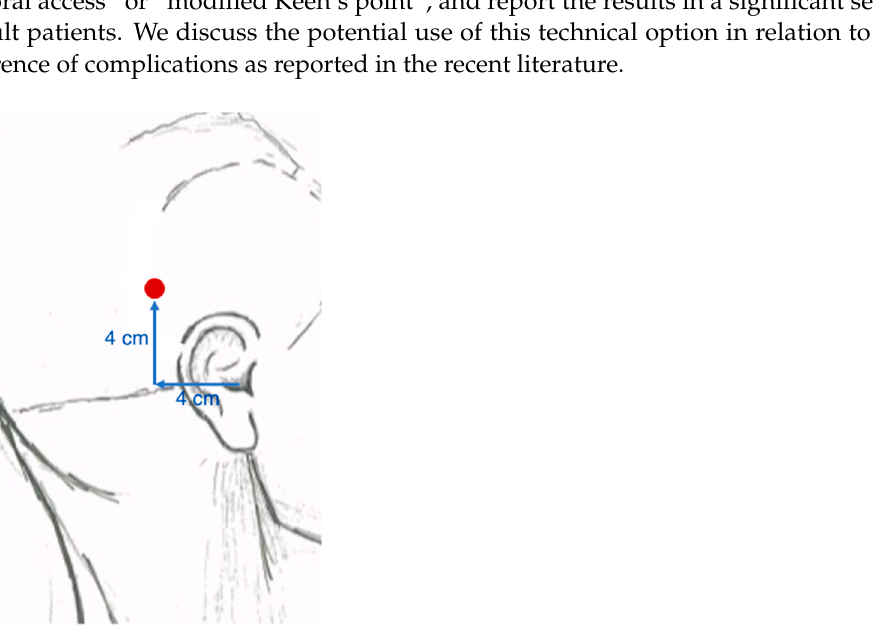
Figure 1. Posterior temporal access or modified Keen’s point (red dot) is taken 4 cm posteriorly and superiorly to the external auditory meatus.